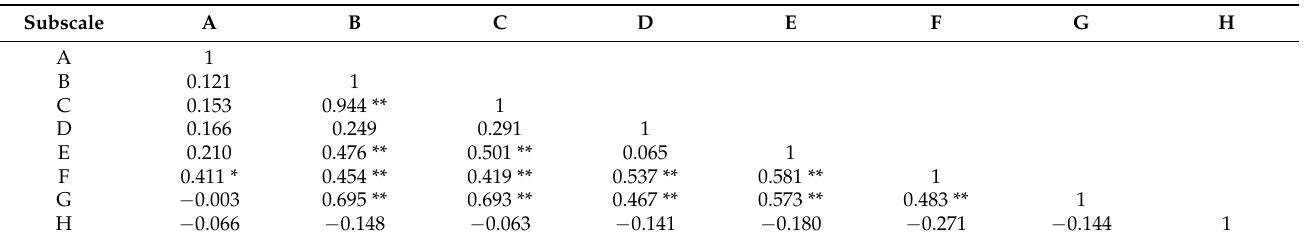
Table 6. Validity—Pearson